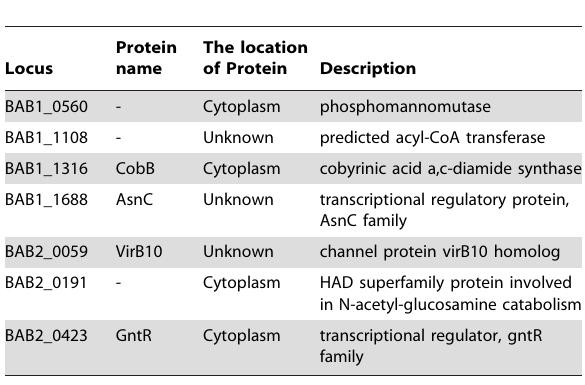
Table 1. Proteins that induced strong T-cell responses in mice immunized with